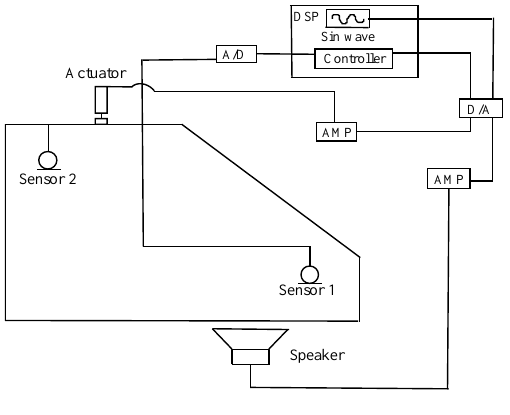
Figure 2. Control system.